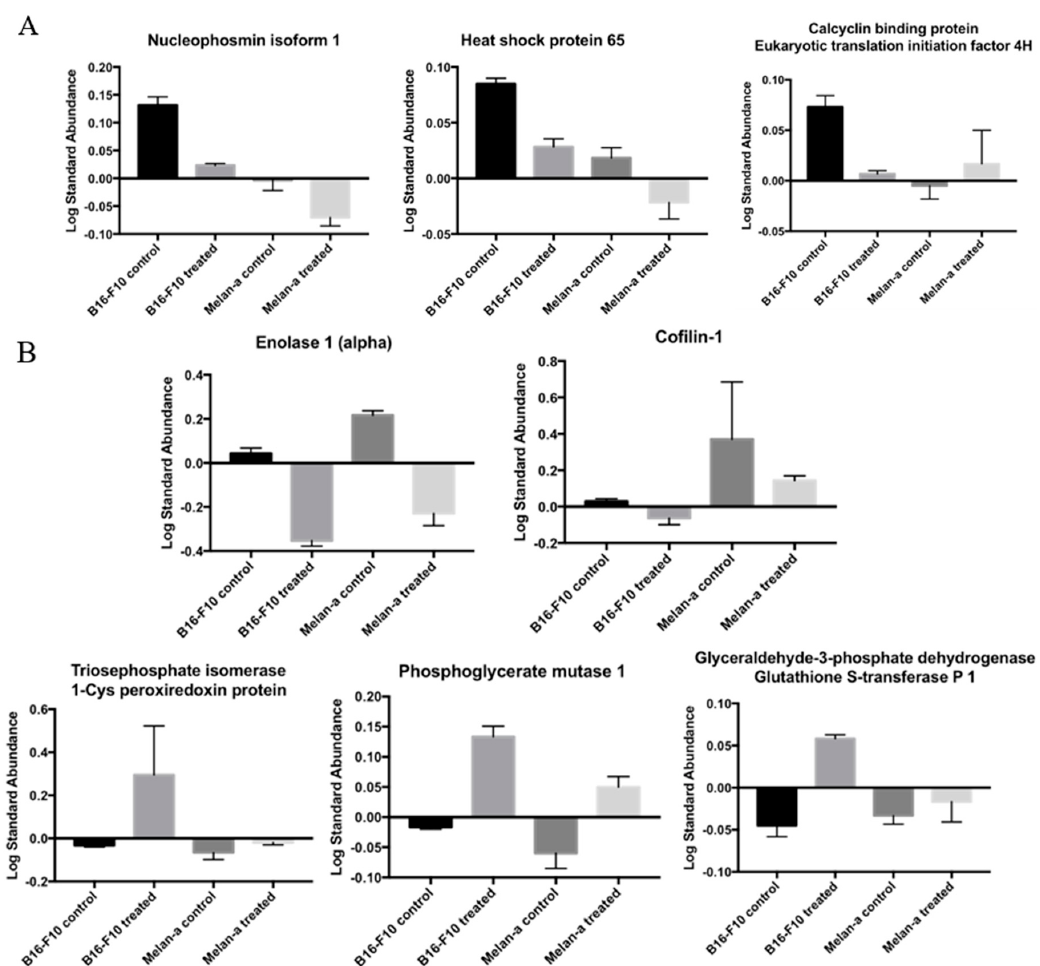
Figure 4. Groups of proteins whose expressions were statistically altered by CMS-2 treatment: ( A ) Group 1 includes proteins whose expression was initially increased in B16-F10 (control) but after CMS ‐ 2 treatment normalized their expression (became similar to Melan ‐ a control); and ( B ) Group 2 includes proteins which after CMS ‐ 2 treatment altered the expression in both cell lines (similar expression in Melan ‐ a control and B16 ‐ F10 control but different expression compared to B16 ‐ F10 treated).